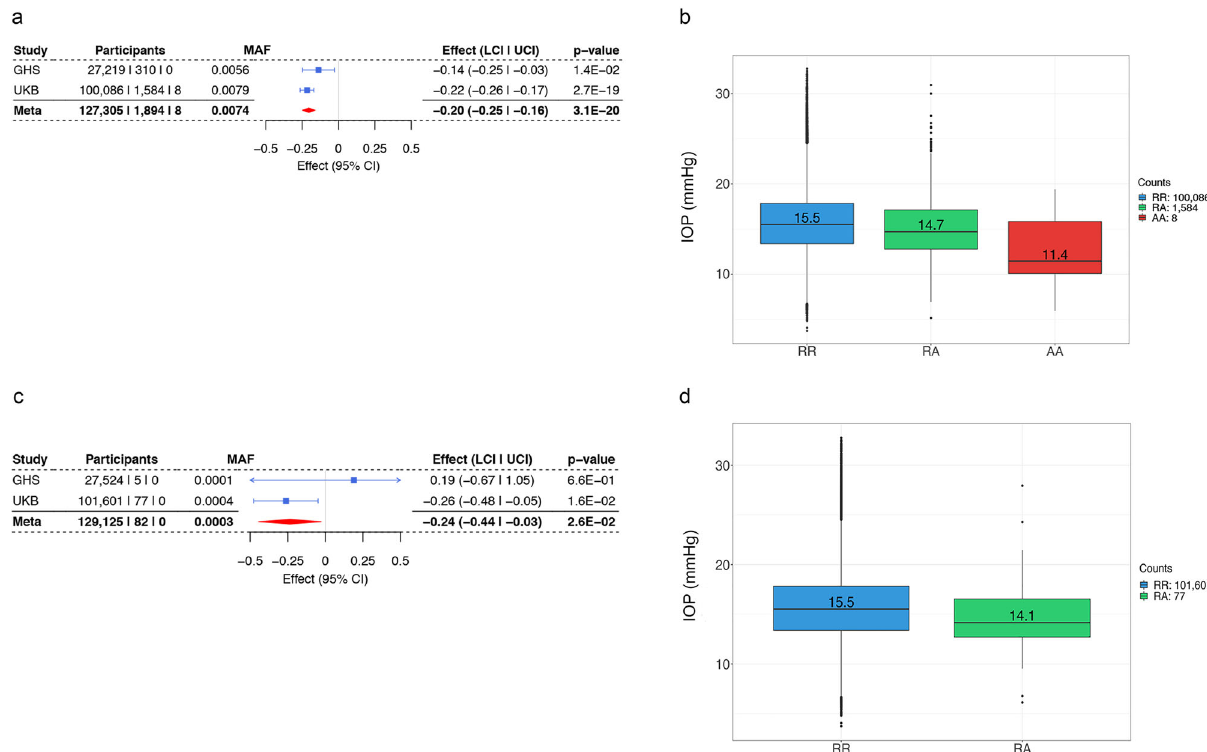
Fig. 2 Gln175His and Arg177* are major contributors to the gene burden association of ANGPTL7 with IOP. Association of Gln175His ( a ) and Arg177* ( c ) variants in ANGPTL7 with IOP, effect measured in standard deviation units, in individuals of European descent. b , d Boxplots representing IOPg in the UK Biobank across genotypes. b Gln175His heterozygous and homozygous carriers have a 0.8-mmHg and 4.1-mmHg lower median IOPg, respectively, compared to non-carriers. d Arg177* heterozygous carriers have a 1.4-mmHg lower IOPg compared to non-carriers. GHS Geisinger DiscovEHR, UKB UK Biobank, MAF Minor allele